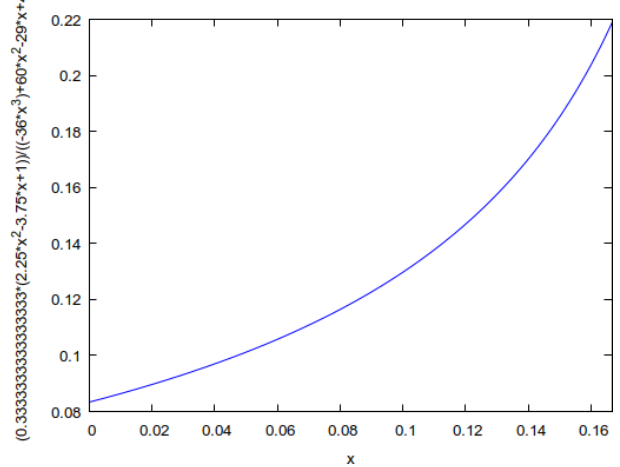
Figure 7: χ (︀ 1 − 15 4 λ + 9 4 λ 2 )︀ with 0 ≤ λ ≤ λ 1